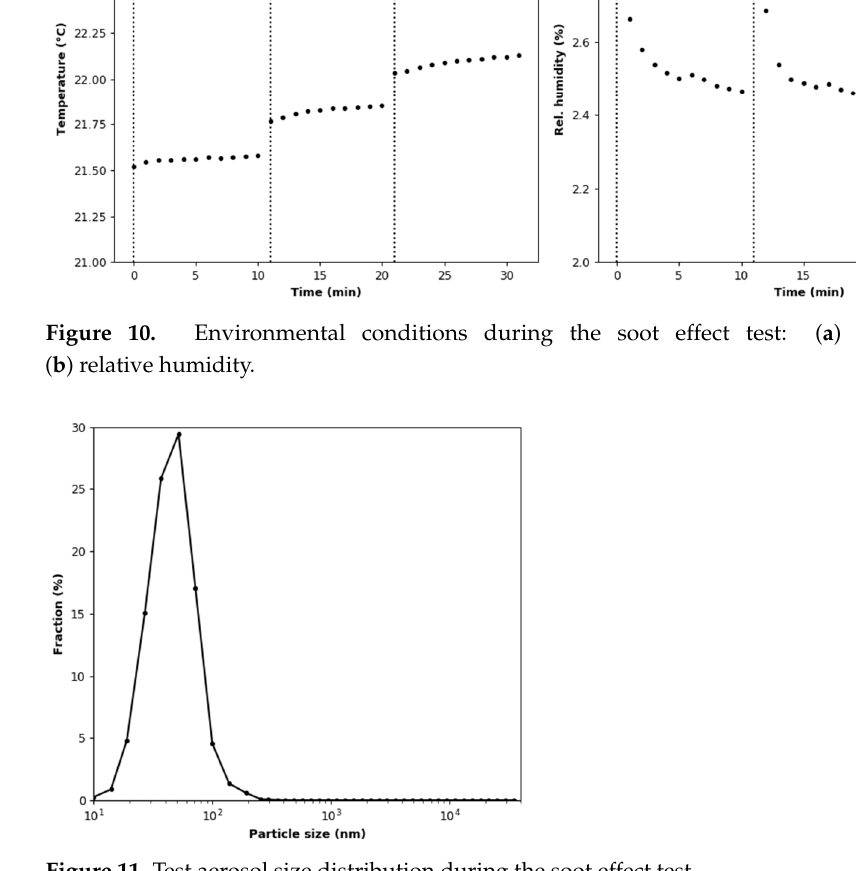
Figure 11. Test aerosol size distribution during the soot effect test.